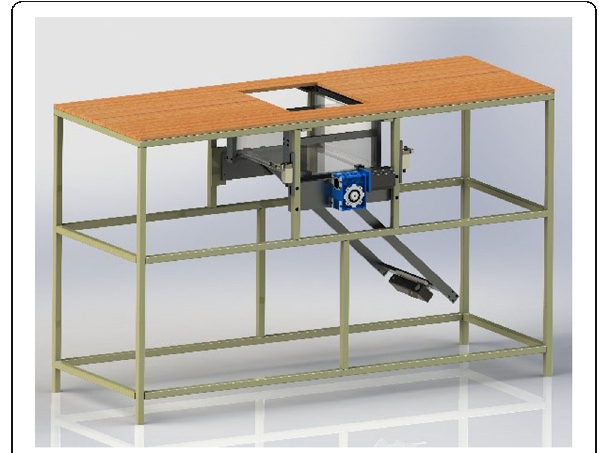
Fig. 1 The self-developed foot shape 3D scanning system based on Kinect